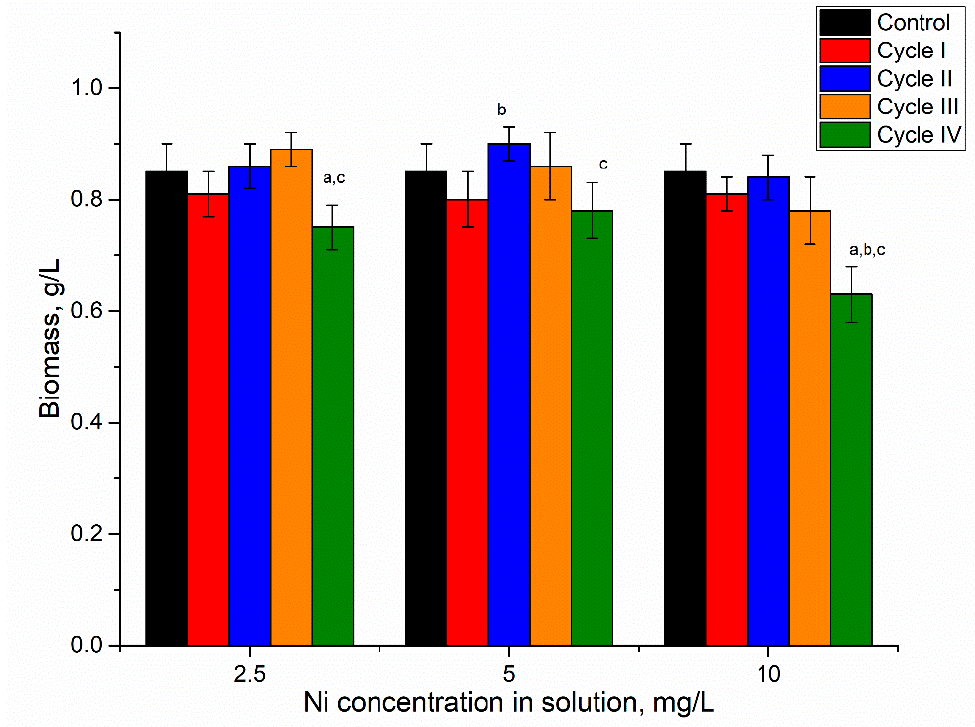
Figure 2. The amount of biomass in spirulina cultivated in a medium containing nickel ions at concentrations of 2.5–10 mg/L during four cycles. a: p < 0.001 for the difference between experimental and control samples; b: p < 0.001 for the difference from the first cycle; c: p < 0.001 for the difference from the second cycle.